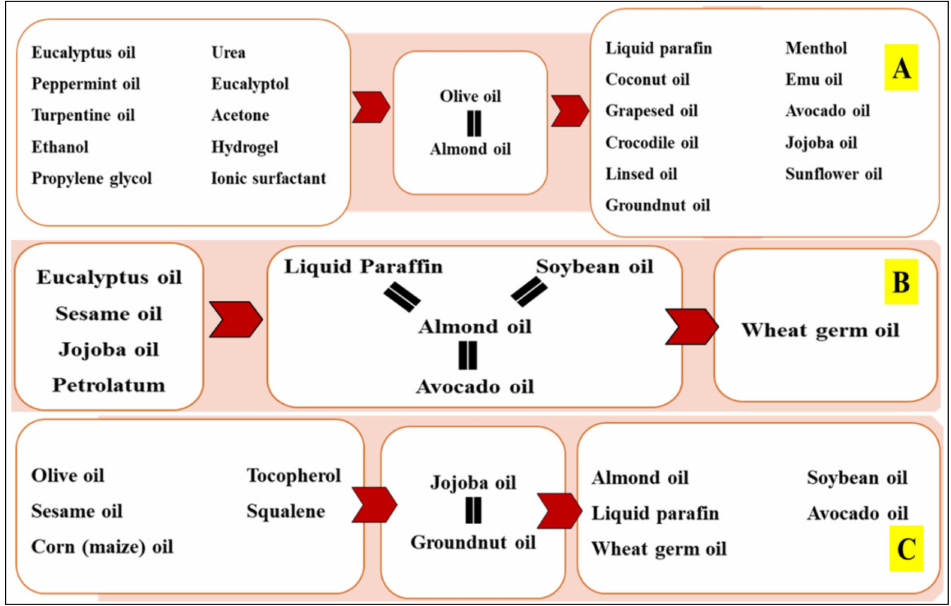
Figure 9. Summary of permeation enhancement activity of terpene essential oils as compared to other chemical enhancers, ( A ) olive oil, ( B ) almond oil, and ( C ) jojoba